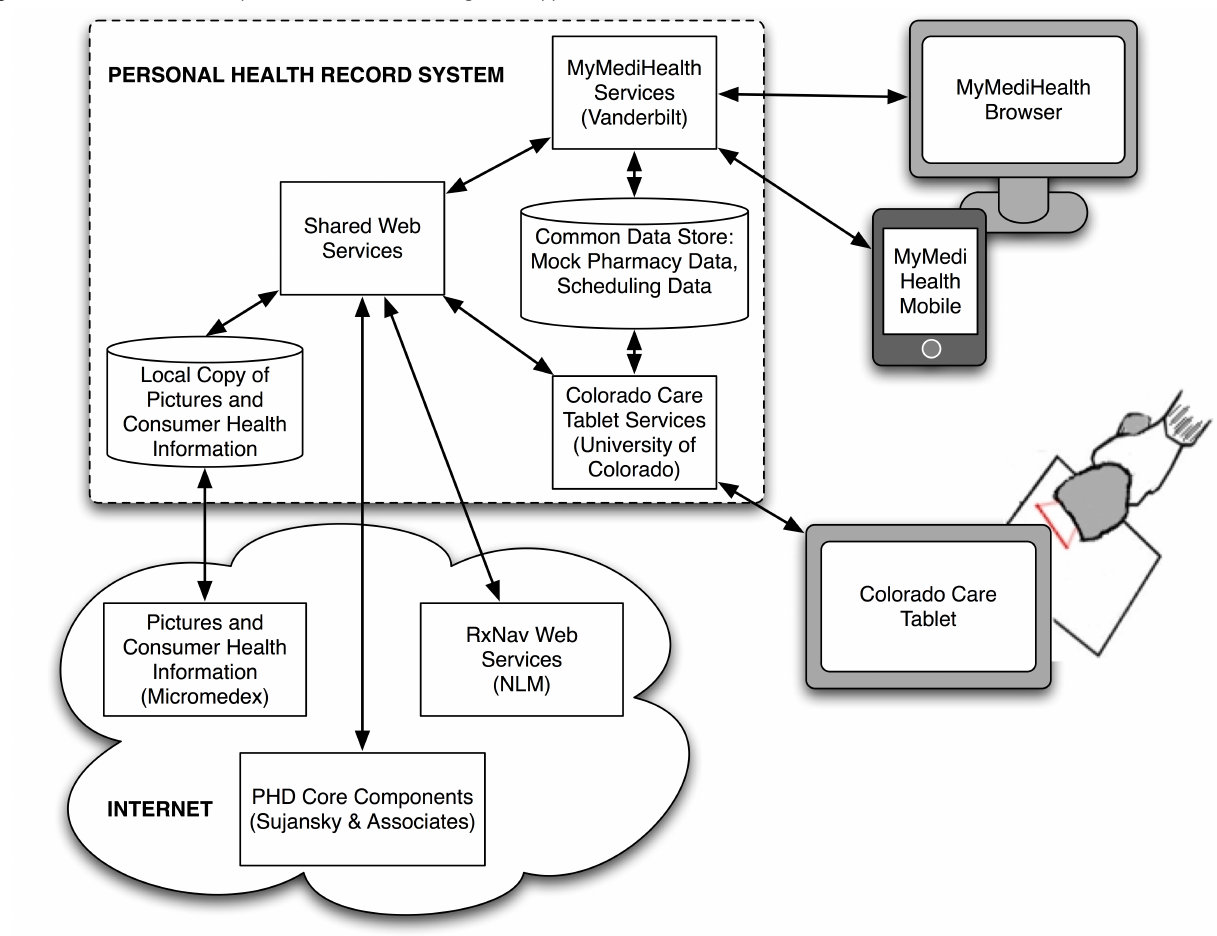
Figure 1. Architecture of two personal medication management applications